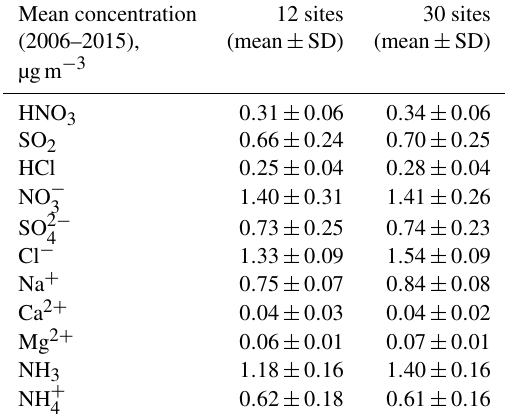
Table 3. Comparison of mean concentrations from the original 12 Acid Gases and Aerosol Network (AGANet) sites vs. the expanded 30 AGANet sites for the different gas and aerosol components. NH 3 and NH + measured at the same time in the UK National Ammonia 4 Monitoring Network (NAMN, Tang et al., 2018) are also included for comparison. Each data point are the mean ± SD of annual mean concentrations over the period 2006 to